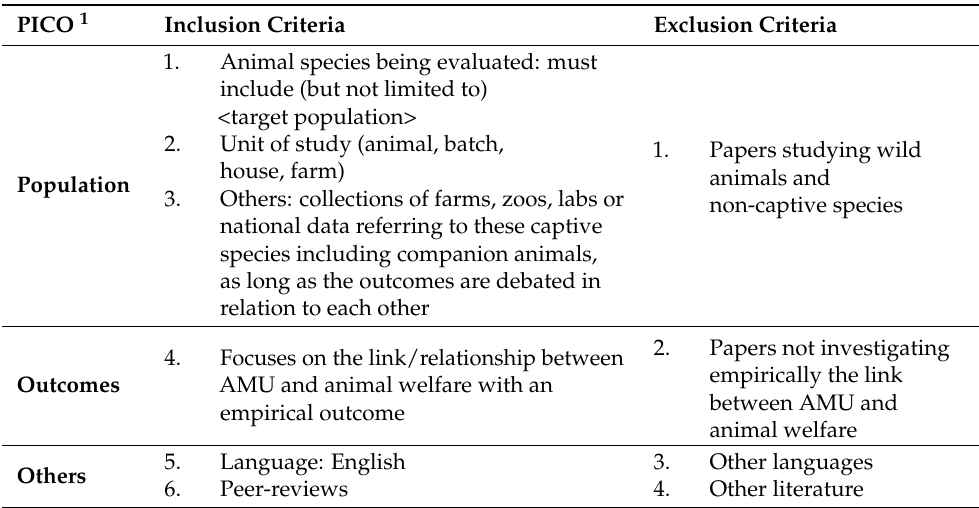
Table 1. Eligibility (inclusion and exclusion) criteria used for the screening of title/abstracts and full